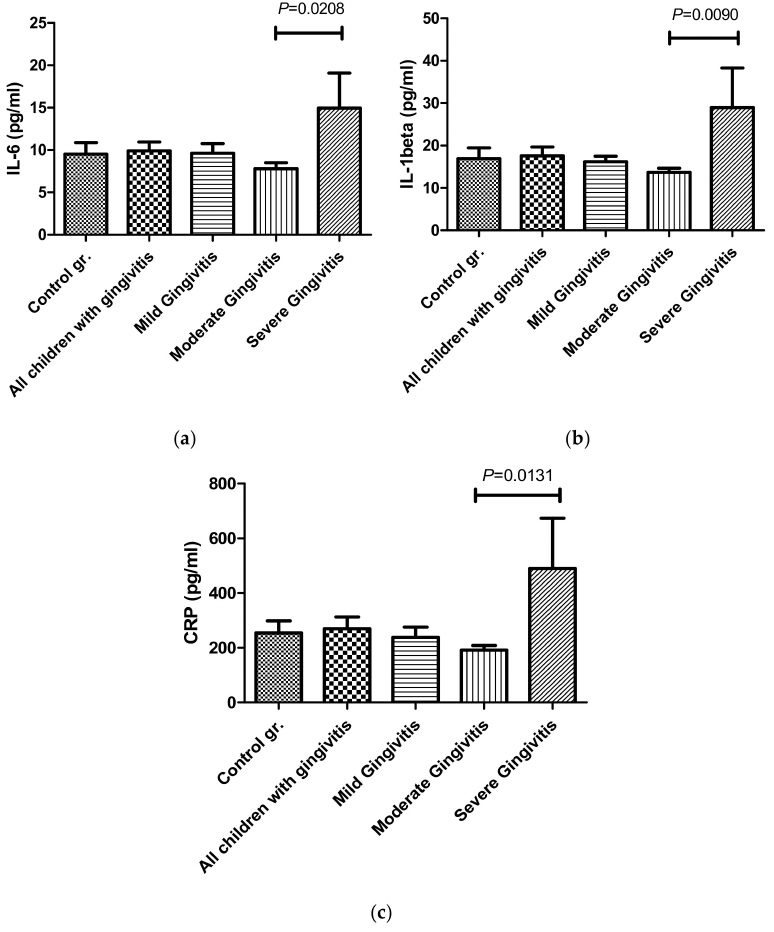
Figure 2. Mean concentrations of ( a ) IL-6, ( b ) IL-1 β , and ( c ) CRP in the saliva of children with different degrees of PIG, the group with all of the children with plaque-induced gingivitis and healthy controls. Data expressed as mean ± SD. Significance level established at p < 0.05. Abbreviations: IL-6—interleukin-6, IL-1 β —interleukin-1 β , and CRP—C-reactive